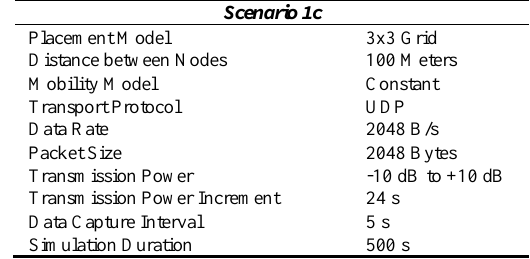
Table 10. Setting under Scenario 1c .